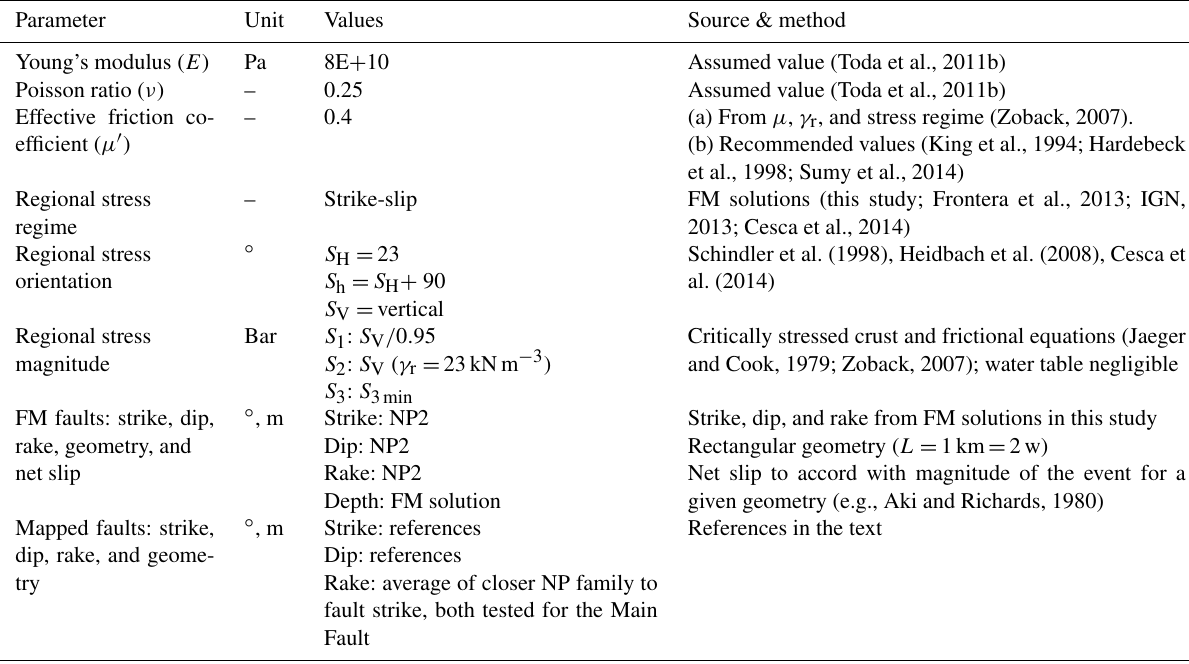
Cesca et al., 2014)